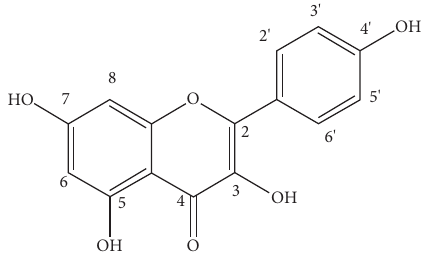
Figure 1: Structure of